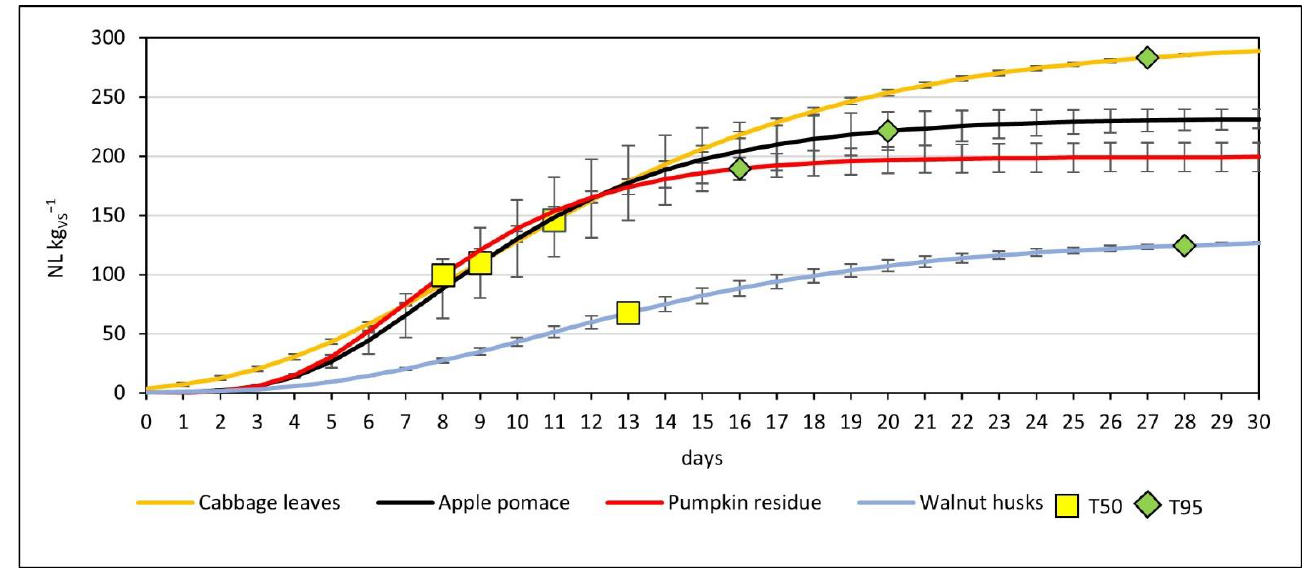
Figure 3. Cumulative methane production of four fruit and vegetable residues. Standard errors are shown as vertical bars. The yellow squares and green diamonds mean T50 and T95, respectively.